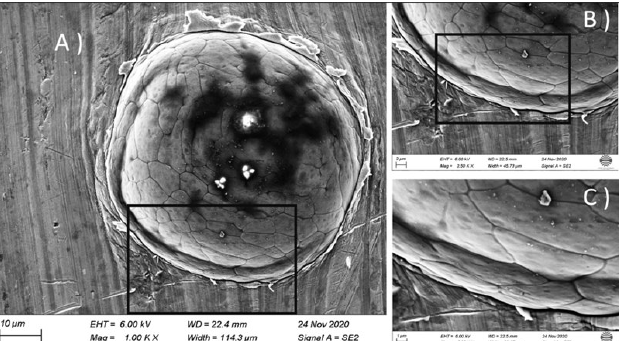
Fig. 6. SEM images with BSE detector of Al splat LASHPOL'ed at 675m.s -1 onto a Al sheet. a), b) and c), top views at different